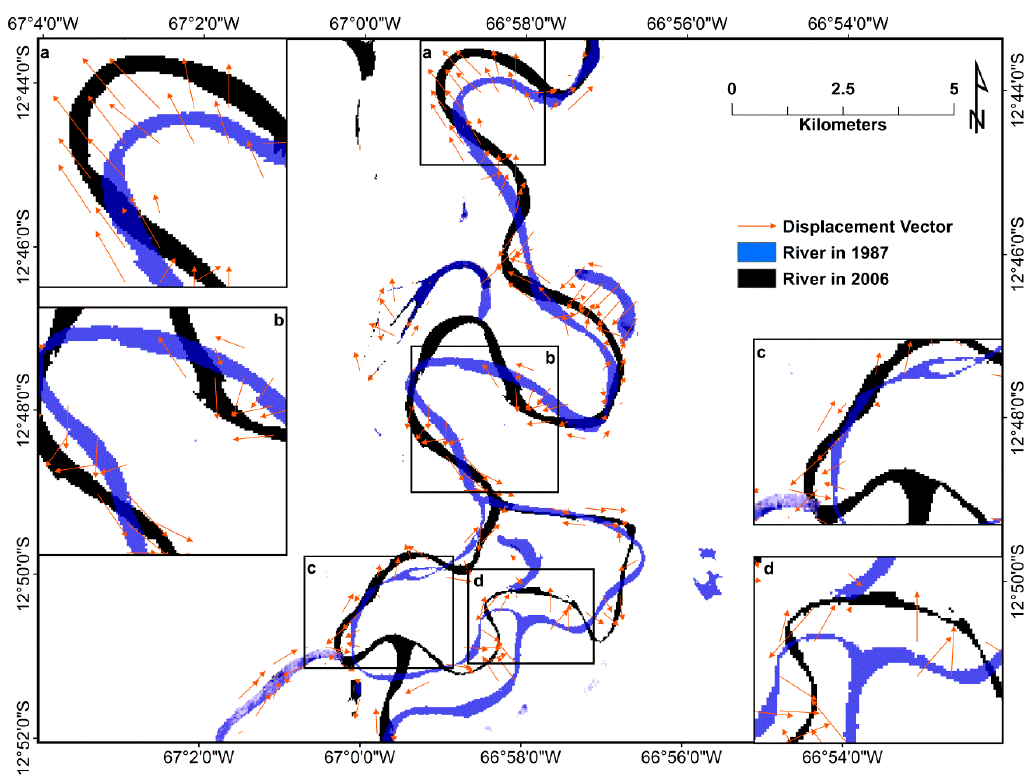
Figure 7. River class-membership images for 1987 and 2006, and MCC vectors (in red) derived from this pair of images. The 1987 river layer and the 2006 river layer (after change) are shown in blue and black, respectively (blue is 30% transparent and overlaid on black layer). Four inset zoom-in windows along the figure margins correspond to their respective specific areas along the river reach, identified by their corresponding labels ( a–d ).